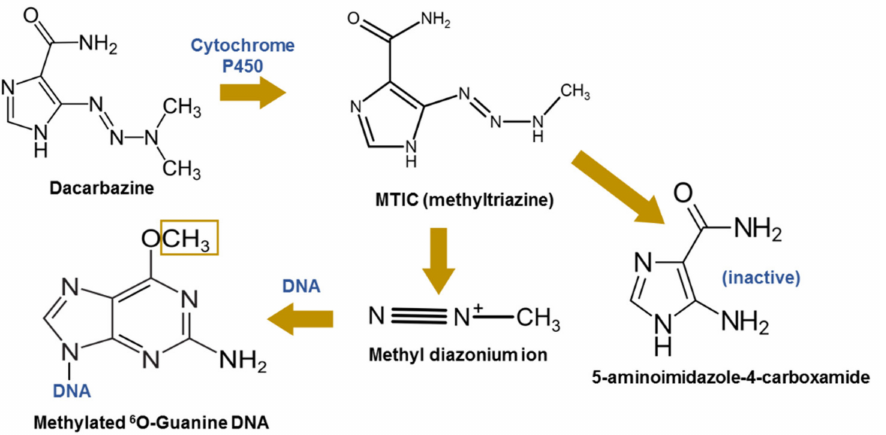
Figure 1. Mechanism of action of